Question: Draft a figure caption describing what is shown.
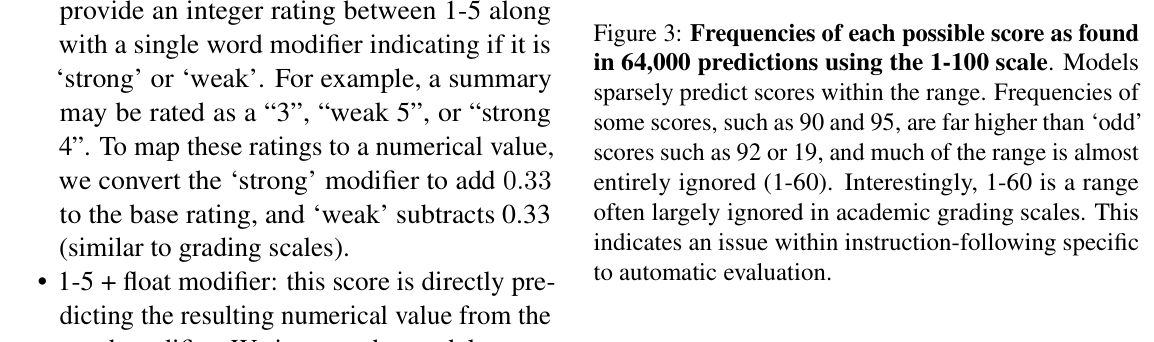
Answer: shows the distribution of scores pro- duced when instructing GPT-3.5-Turbo and GPT-4 to rate summaries on a 1-100 scale. The scores in this distribution are not respected as intended, and the model assigns outsized probabilities to certain scores such as 90 and 95. This reaffirms results by Zheng et al. (2023a) which found that multiple- choice selections by LLMs suffered from similar token biases, deteriorating performance. The full range is also not utilized, with predicted scores largely occurring between 70 and 100. Figure 3 also shows that the score distribution has several peaks for round numbers such as 60, 70, 80, 90 (Similarly for 75, 85, and 95), indicating that LLM evaluators also have round number bias like human.2